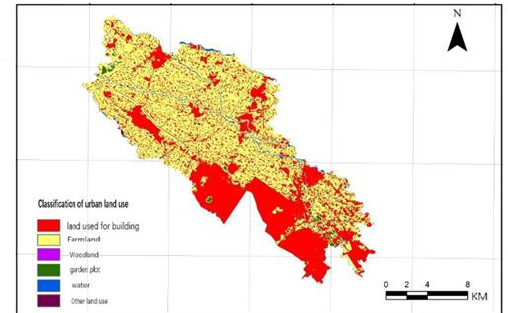
Figure 6 Comparison of simulation results for 2012